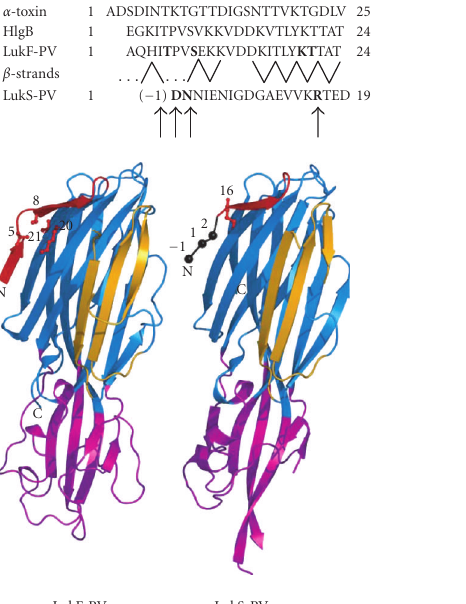
ADSDINTKTGTTDIGSNTTVKTGDLV EGKITPVSVKKVDDKVTLYKTTAT AQHI T PV S EKKVDDKITLY KT TAT